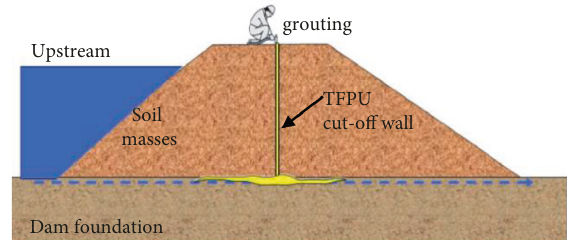
Figure 1: Schematic diagram of the construction of the two- component foaming polymer (TFPU) cut-off wall in soil dams